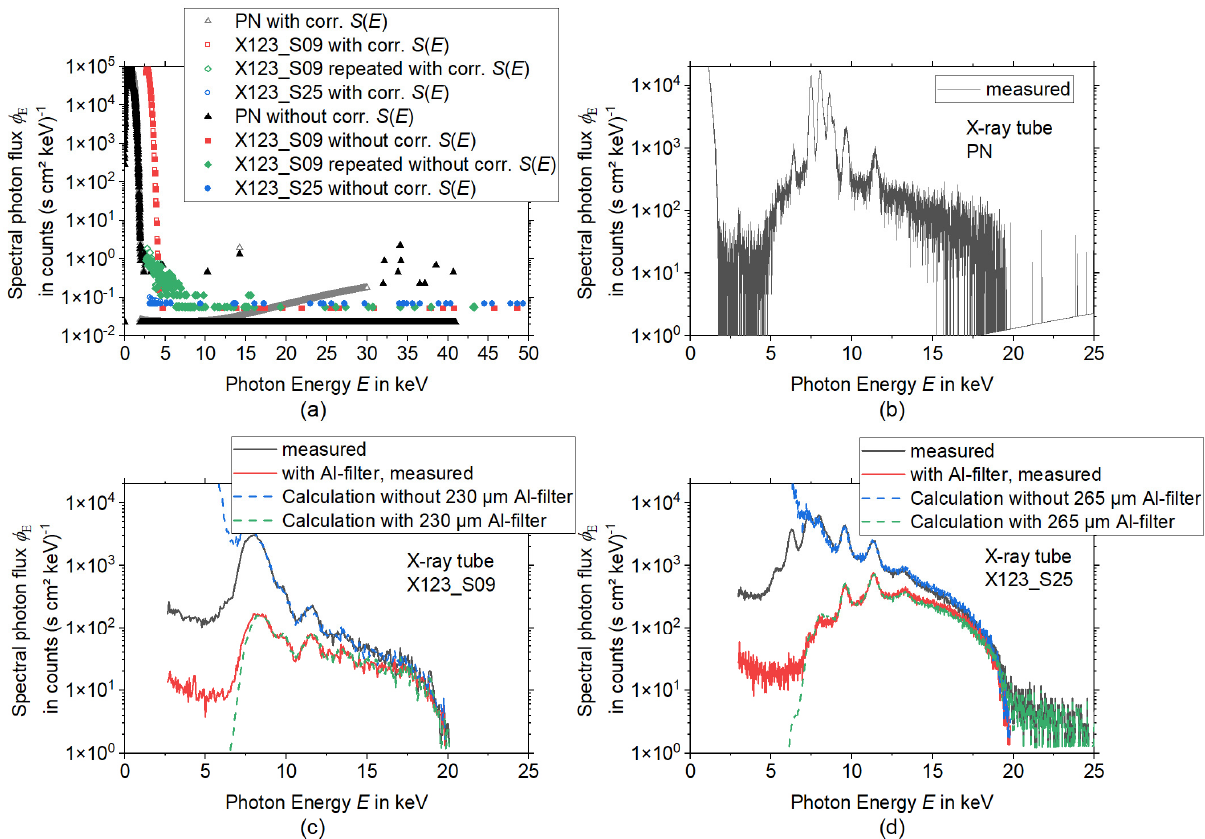
Figure 3. Characterization of the spectrometers without laser material processing, ( a ) Background measured inside the running USPL machine without laser processing (with and without correction of the spectral sensitivity of the sensor S ( E )), ( b ) X-ray tube spectrum measurement with the PN spectrometer, ( c ) X-ray tube spectra measured with X123_S09 with and without Al-filter (solid lines) along with two calculated spectra (dashed curves), ( d ) X-ray tube spectra measured with X123_S25 with and without Al-filter (solid lines) along with two calculated spectra (dashed curves). Note the logarithmic scaling of the ordinate axes.